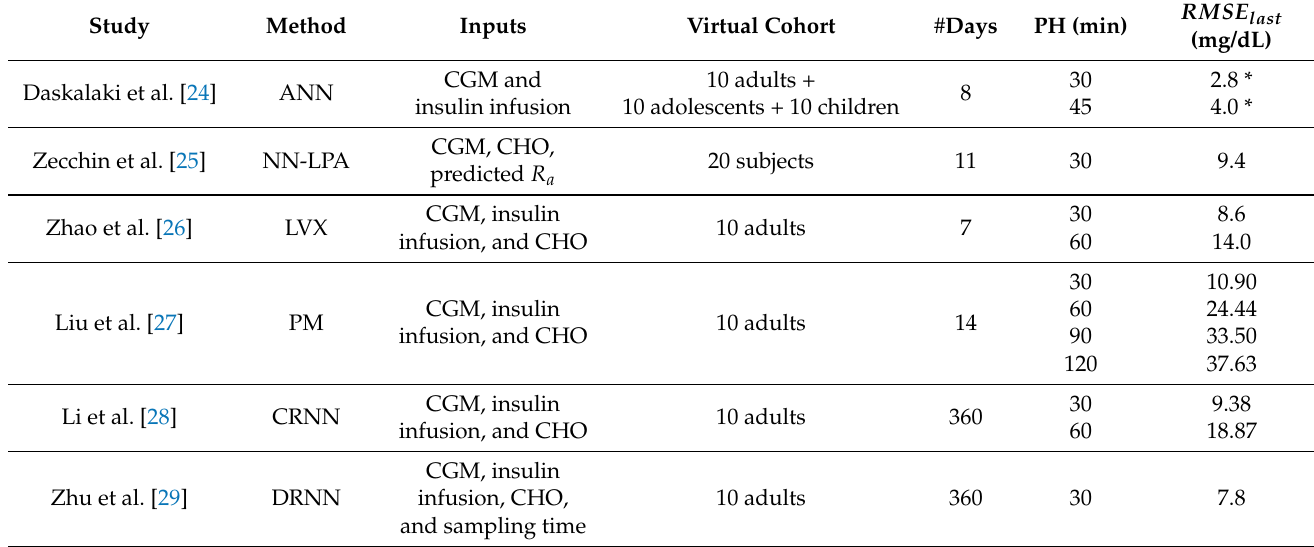
Table 7. Prediction error of different literature methods with in silico studies. Acronyms: ANN (artificial neural network), NN-PLA (neural network plus linear prediction algorithm), LVX (latent variable-based model), PM (physiological model), R a (glucose rate of appearance from a meal). * data for the adult